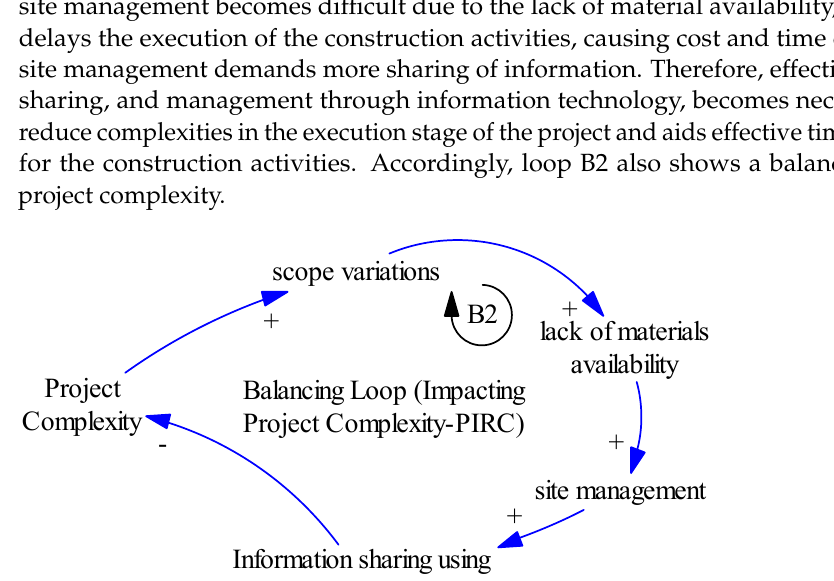
Table 5. Loop analyses results.